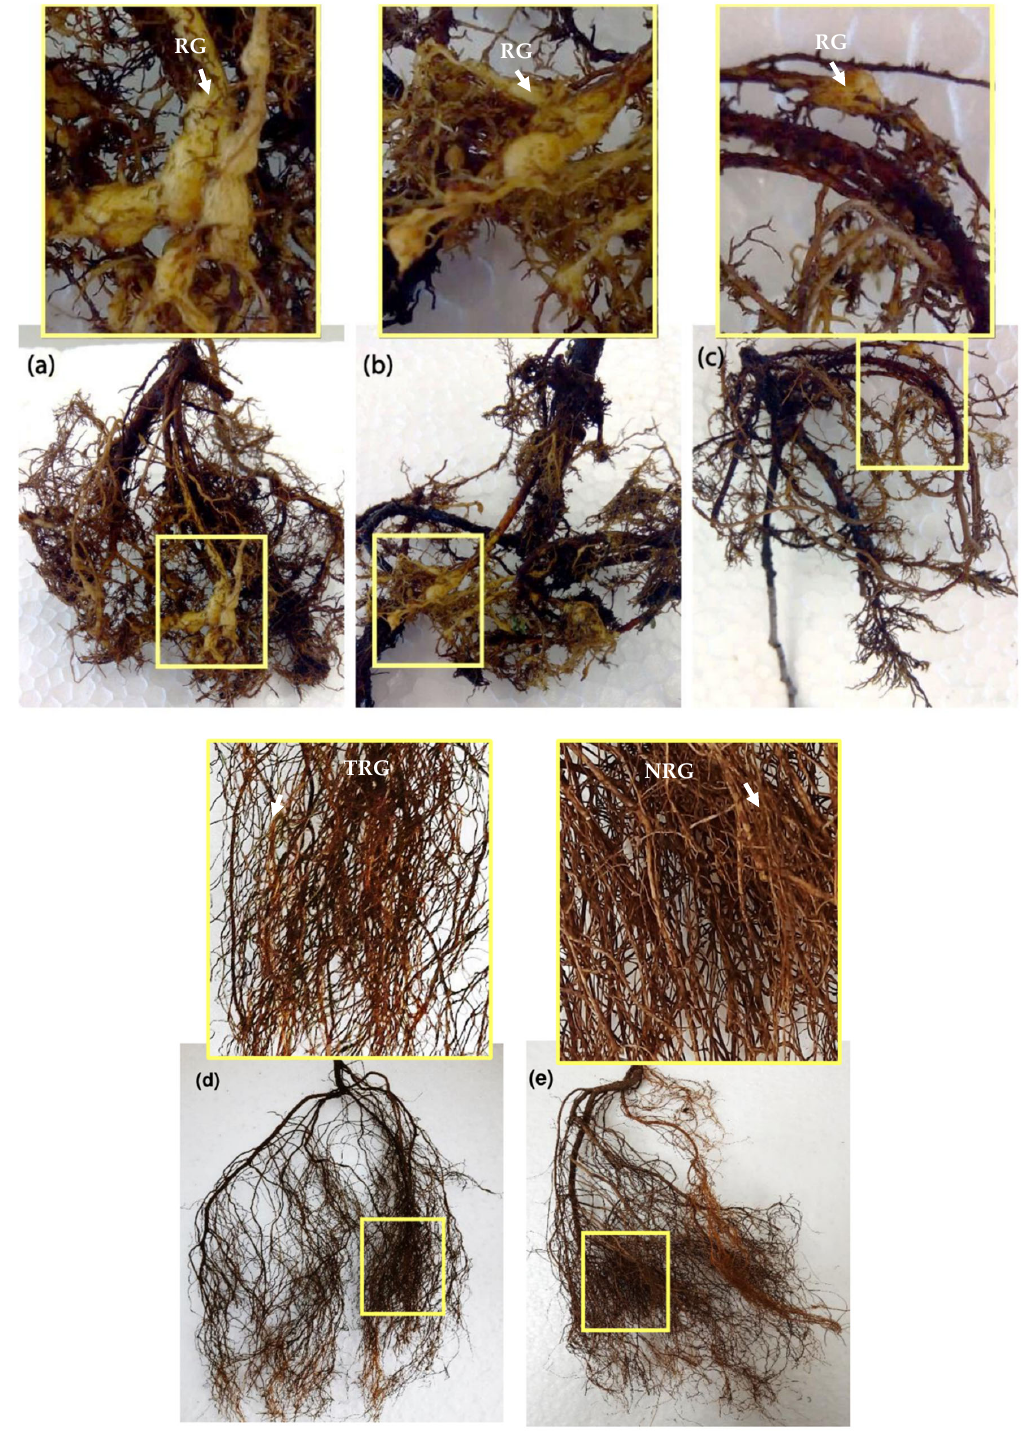
Figure 6. Photographs of the root system of treated and untreated F. deltoidea plants. ( a ) 0 mM H 2 O 2 (control), ( b ) 15 mM H 2 O 2 , ( c ) 30 mM H 2 O 2 , ( d ) 60 mM H 2 O 2 , and ( e ) 90 mM H 2 O 2 . Many root galls (abnormal growth in the root) caused by root ‐ knot nematode are visible in the control and 15 mM H 2 O 2 treated plants, whereas, a lower number and tiny root galls in 60 mM treatment and no root gall in the 90 mM H 2 O 2 treated plants were seen. A well ‐ developed root system with many lateral roots were visible in both the 60 and 90 mM H 2 O 2 treatments. Abbreviations: RG ‐ Root gall, TRG ‐ Tiny root gall, and NRG ‐ No root gall.